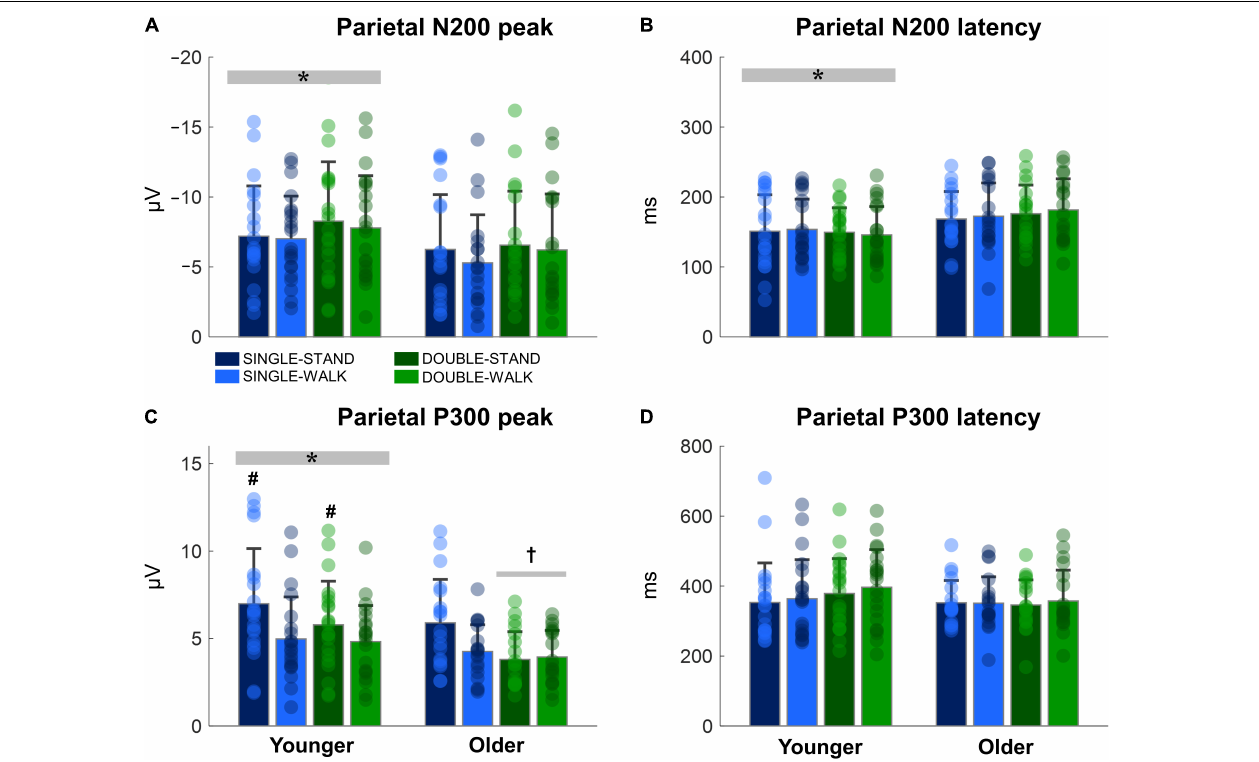
FIGURE 6 | Mean (SD) and individual values of N200 peak (A) , N200 latency (B) , P300 peak (C) , and P300 latency (D) in four conditions for the channel Pz: single stimulus while standing (SINGLE-STAND), single stimulus while walking (SINGLE-WALK), double stimuli while standing (DOUBLE-STAND), double stimuli while walking (DOUBLE-WALK) for younger and older adults. *Denotes significant difference in relation to older adults ( p < 0.05). † Denotes significant difference in relation to single stimuli conditions for the same group ( p < 0.05). # Denotes significant difference in relation to walking conditions for the same group ( p <